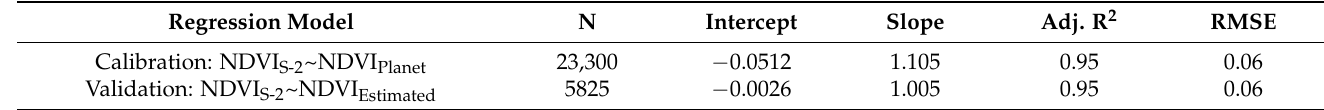
Table 4. Estimating the S-2 NDVI values using Planet imagery 1